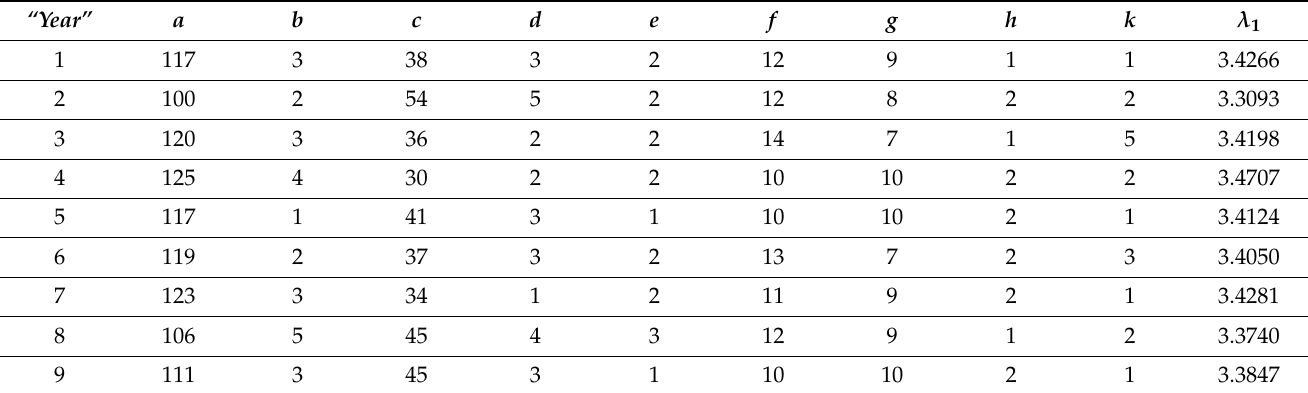
Table 3. Example 3: Nonzero elements of the 9 Calamagrostis epigeios PPMs to be